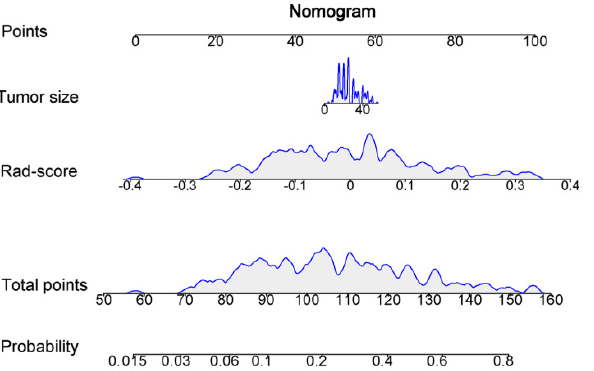
Figure 8. Nomogram based on the combination of the tumor size and Rad-score was developed using logistic regression analysis.